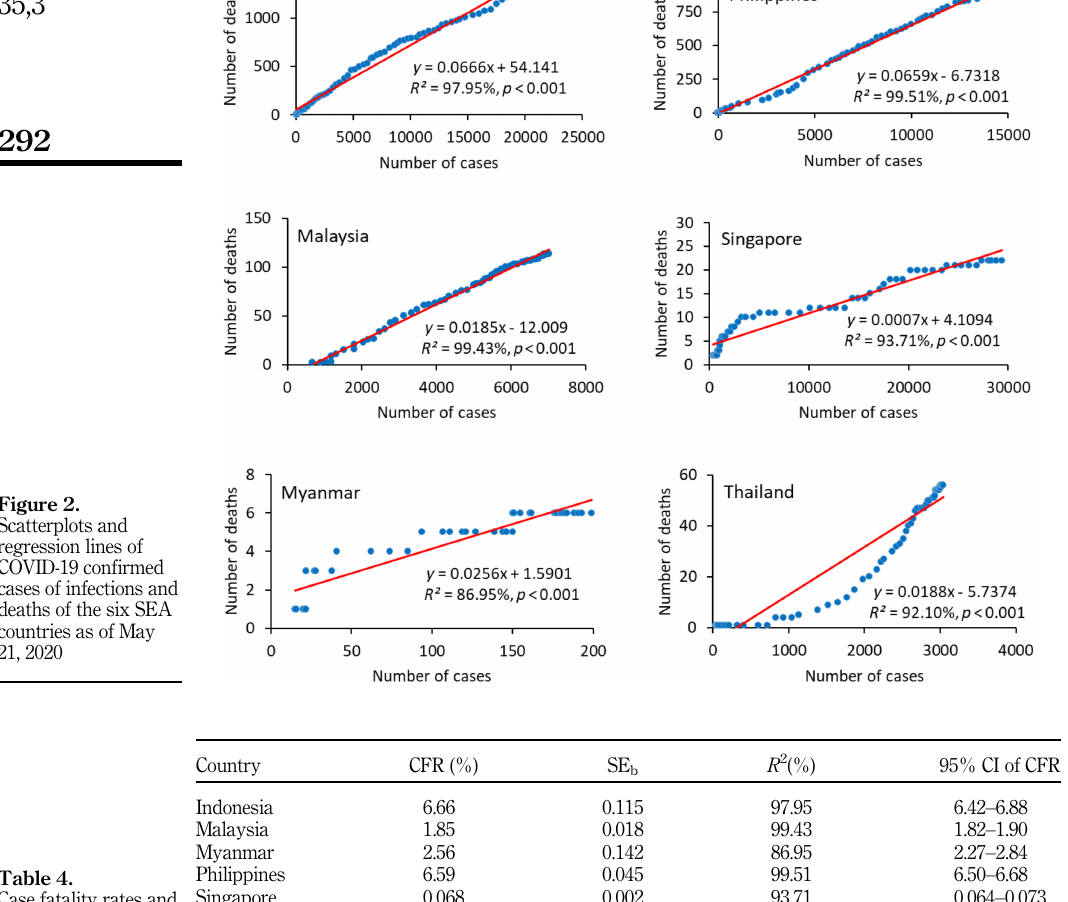
Table 4. Case fatality rates and other statistics